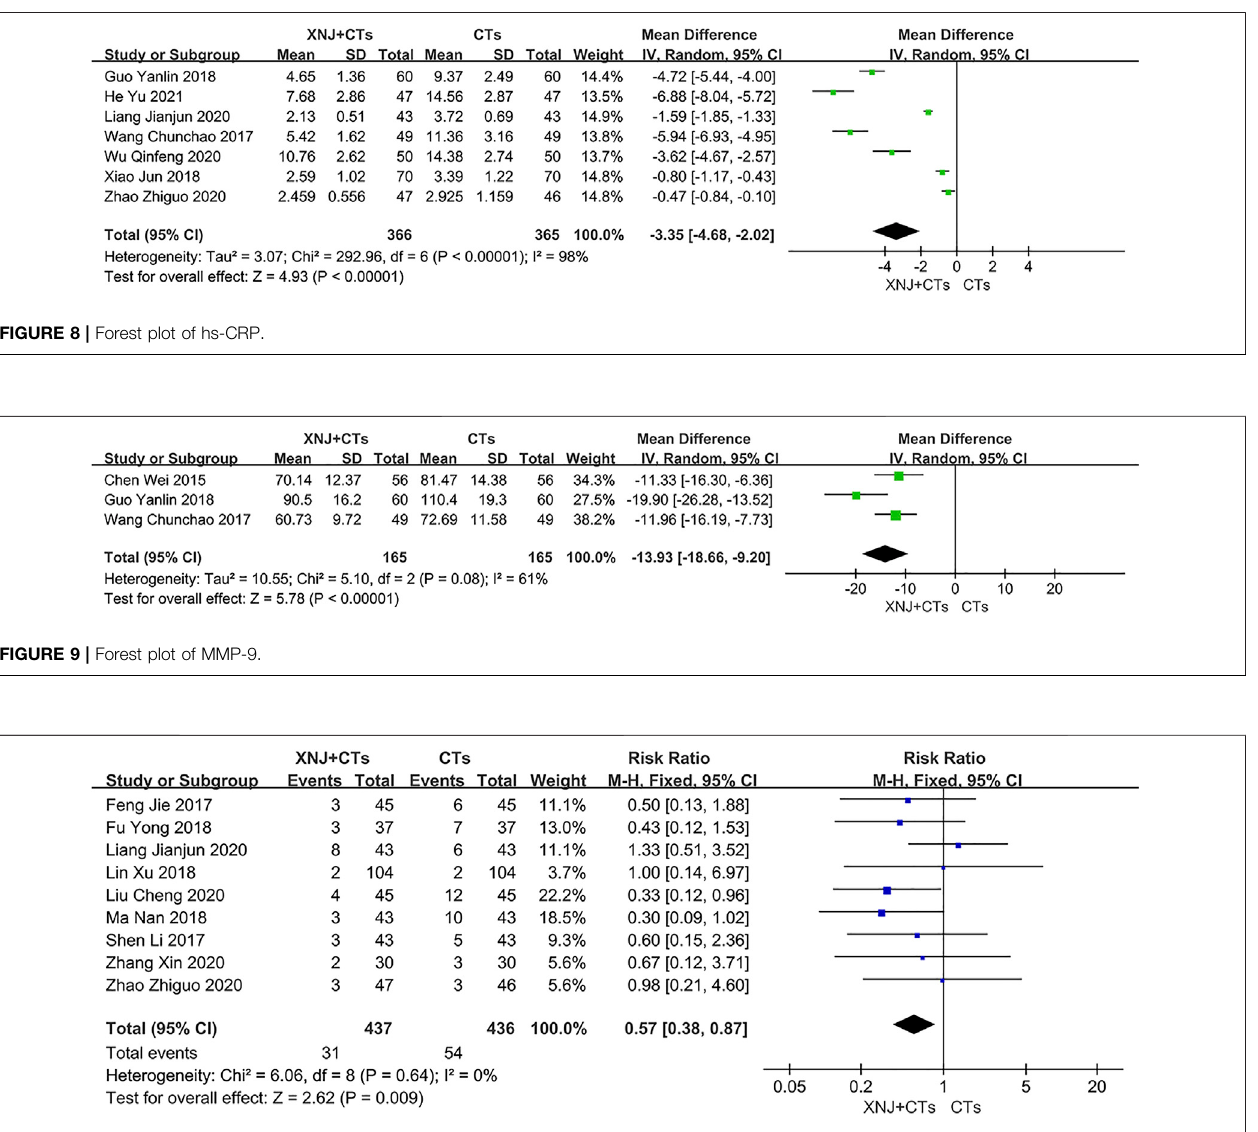
FIGURE 10 | Forest plot of incidence of adverse